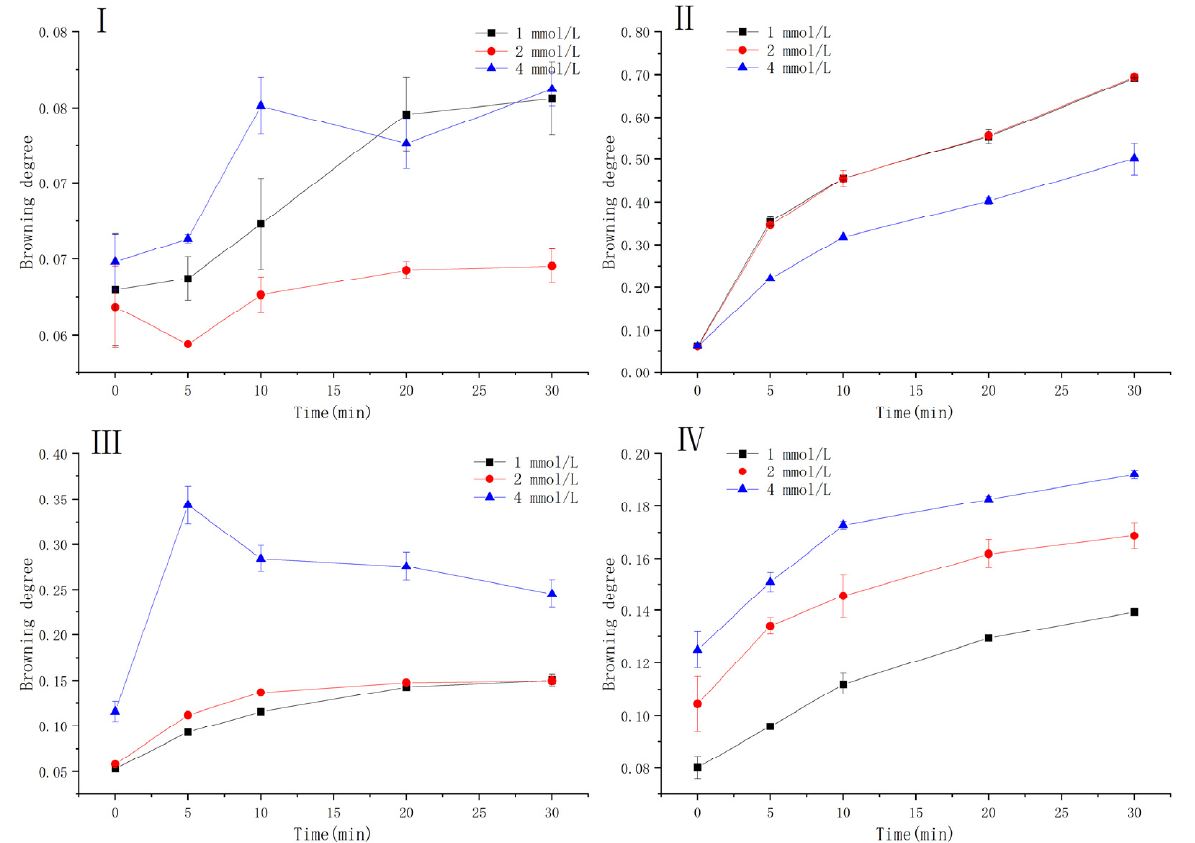
Figure 6. The browning degree of enzymatic browning products of ( I ) Catechin ( II ) Epicatechin ( III ) Caffeic acid ( IV ) Chlorogenic acid in various concentrations at pH 6.8.